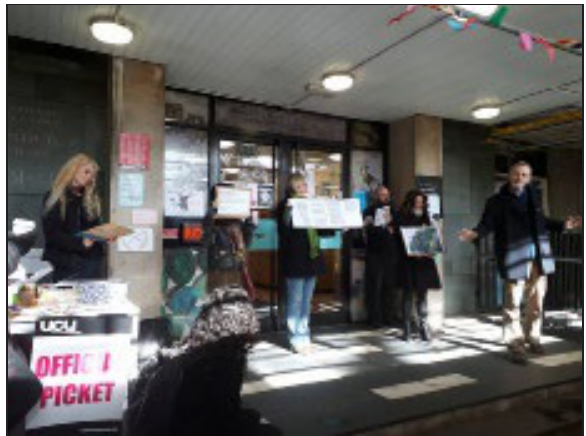
Figure 2: Teach-out ‘Archaeology of strikes and revolution’ on the steps of the UCL Institute of Archaeology, 13th March 2018 (Photo: Mariana Peters